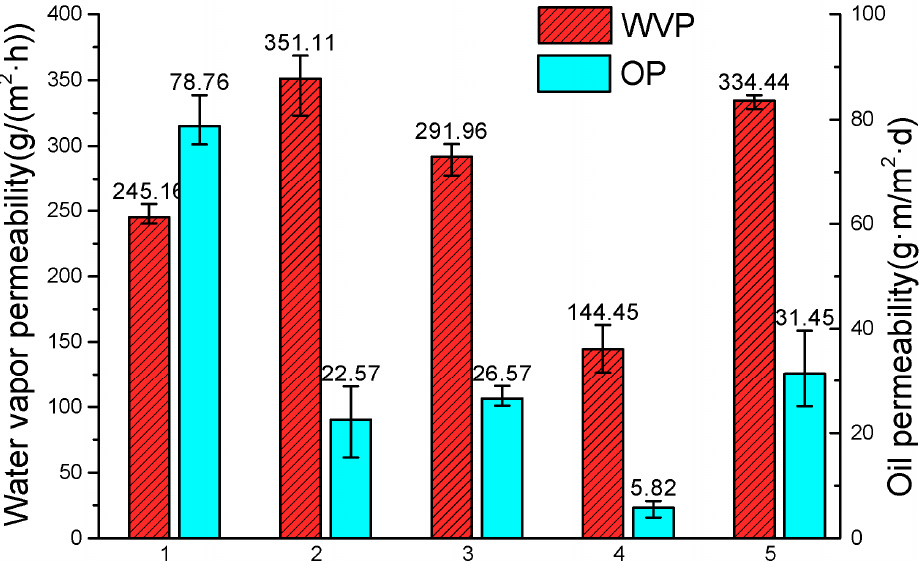
Figure 7. Gas permeability of SPI and fractioned product films: (1) SPI, (2) lower protein, (3) upper protein, (4) 11S globulin, and (5) 7S globulin.